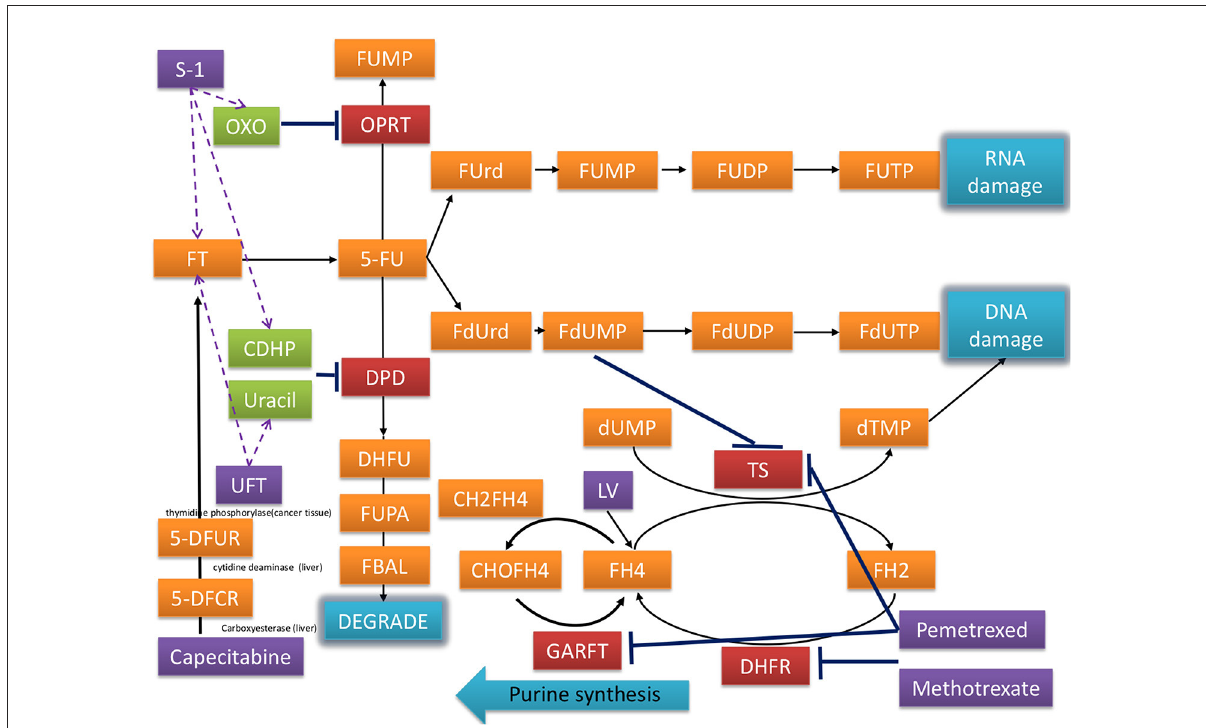
FIGURE1 Mechanisms of fluorouracil-related medications including UFT, capecitabine, S-1, and others in the treatment of